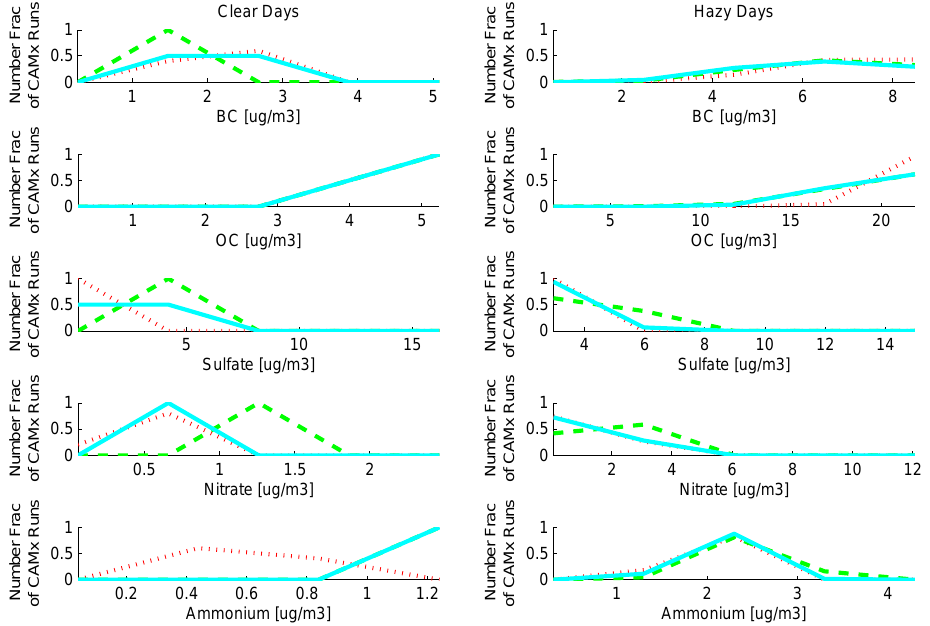
Fig. 7: PDFs of the number of CAMx runs matching the entire set of concentrations for the Singapore site. The x-axis is the concentration of each respective species, during each time period considered at the Singapore site, while the y-axis is the normalized number count in terms of the number of CAMx runs matching all 5 species (Table 8). The different colors refer to the different meteorologies for each metamodel.